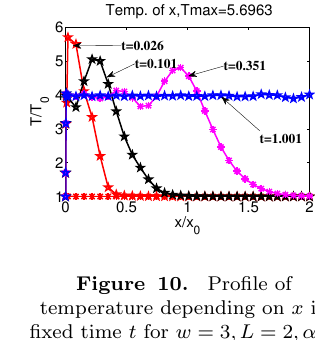
Figure 10. Profile of temperature depending on x in fixed time t for w = 3 ,L = 2 ,α = 6 ,P 1 = 0 . 01 ,P 2 = 0 .